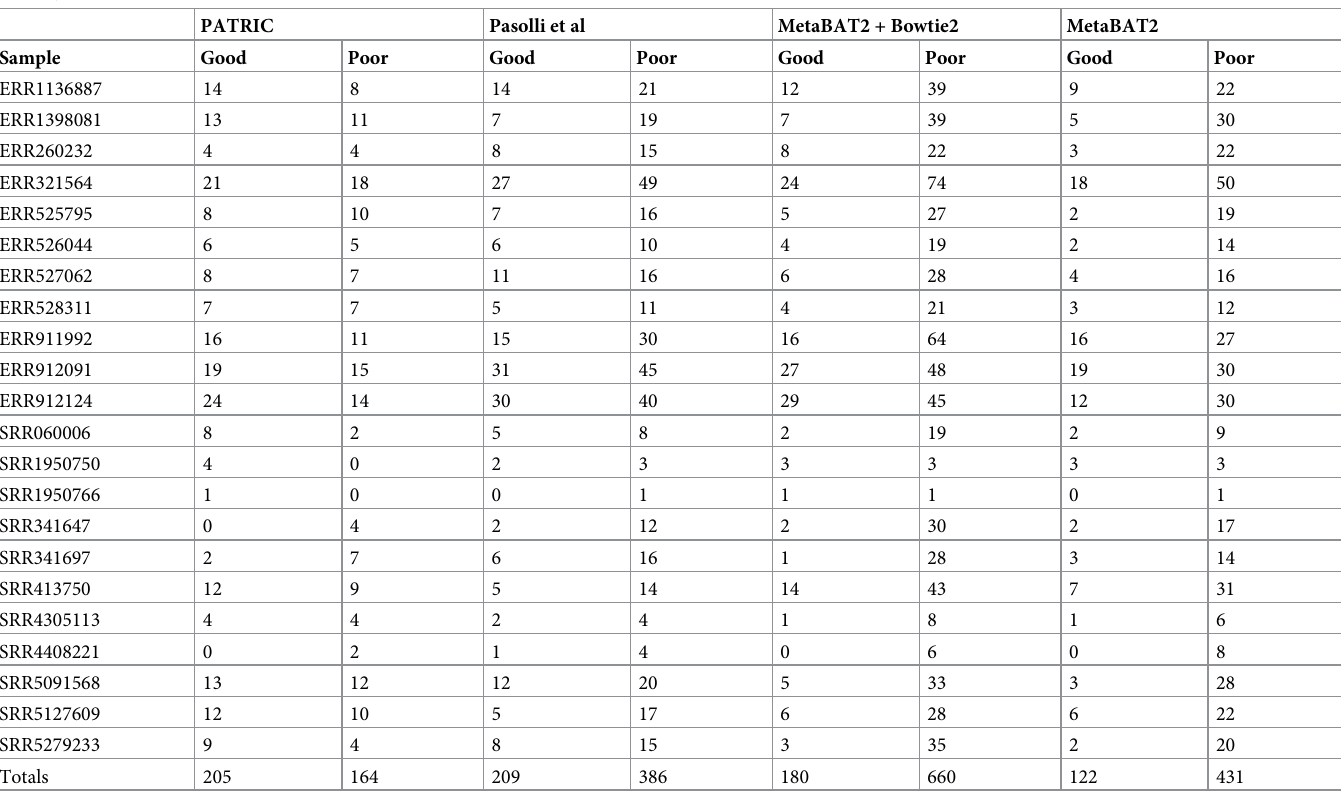
Table 3. Benchmarks for various binning methods. 24 samples from the Pasolli et al study were run through the PATRIC binning tool, MetaBAT2 with depth files gener- ated from the original FASTQ reads using Bowtie2, and MetaBAT2 on raw contigs. These bins were compared to the results generated in the Pasolli et al study via a custom pipeline which also used Bowtie2 and MetaBAT2. Each studied group splits found bins into “good” bins, i.e. those matching the PATRIC criteria for a high-quality bin, and “poor” quality bins which do not meet the criteria. In general, PATRIC found more high-quality bins than MetaBAT2 with or without alignment, although theoreti- cally better MetaBAT2 performance is demonstrated via the Pasolli et al study. The PATRIC binning tool found substantially fewer poor-quality bins than any of the other binning